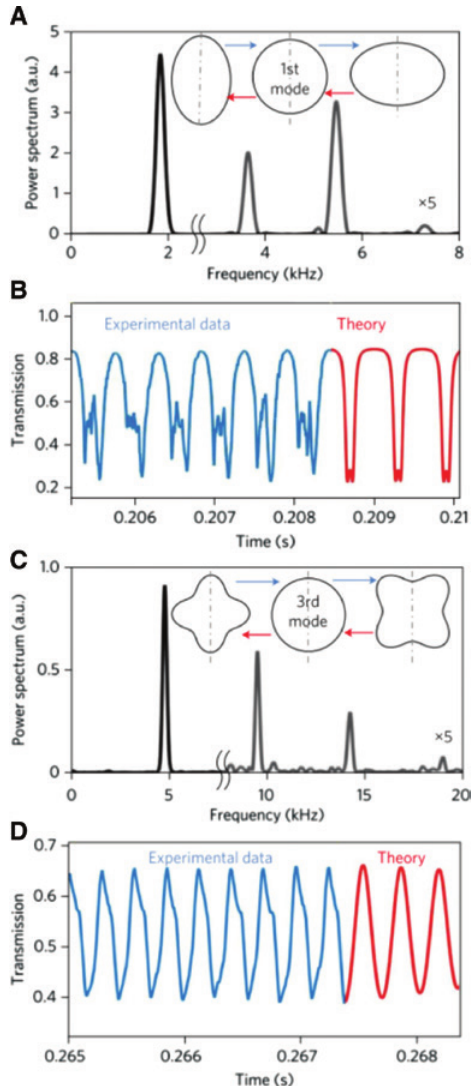
Figure 7: Interactions between light and capillary oscillations of liquid